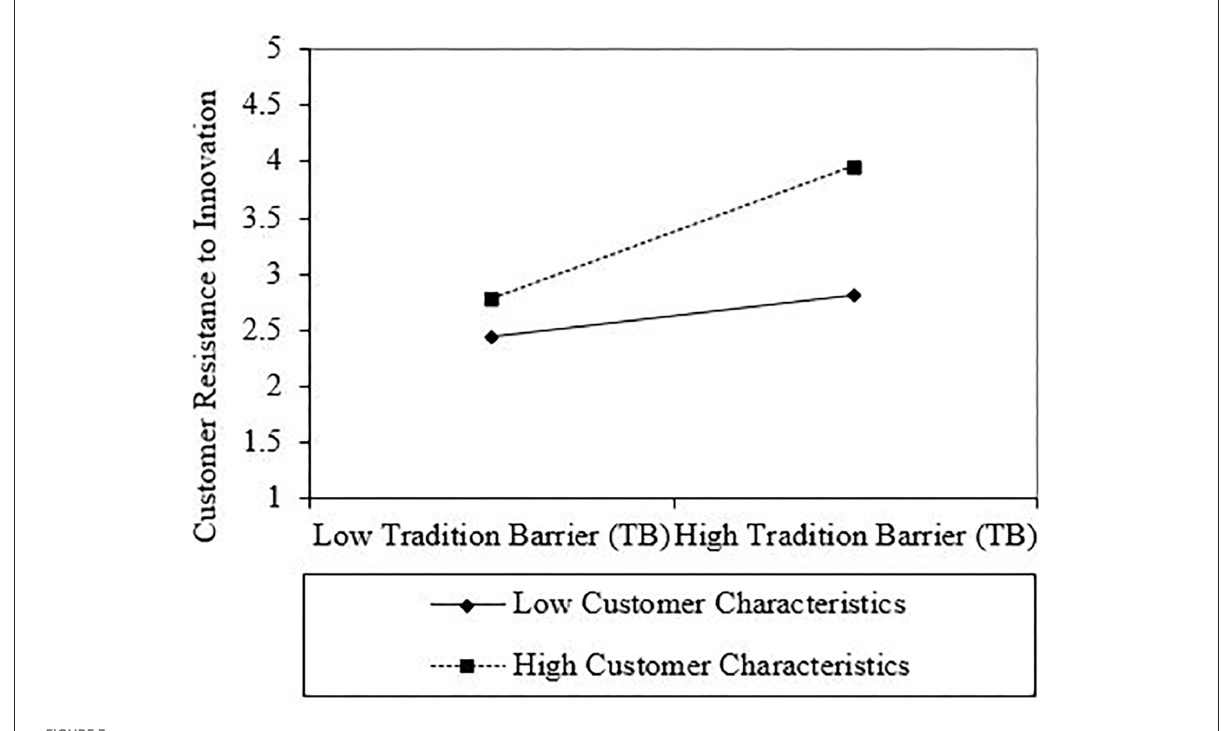
FIGURE3 Interaction plot of tradition barrier (TB) and customer characteristics interaction on the customer resistance to